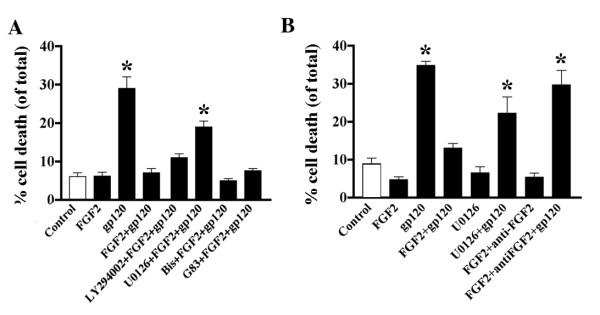
Viability assays indicate that ERK activation is required for FGF2 protection against gp120 (A) Trypan Blue Exclusion assay for cell survival after 30 min of treatment with inhibitors LY294002, U0126, Bis I, or Gö6983 followed by treatment with FGF2 and/or gp120. (B) Trypan Blue Exclusion assay for cell survival after 30 min of treatment with the MEK inhibitor U0126 alone, and followed by exposure to gp120 and/or FGF2 for 24 h. In cells treated with FGF2 and anti-FGF2, HUVEC were exposed to anti-FGF2 antibody for 1 h followed by treatment with FGF2 alone or in combination with gp120. * Indicates a significant difference from control. * = P < 0.05 by One-Way ANOVA with post-hoc Dunnett's when compared to control.